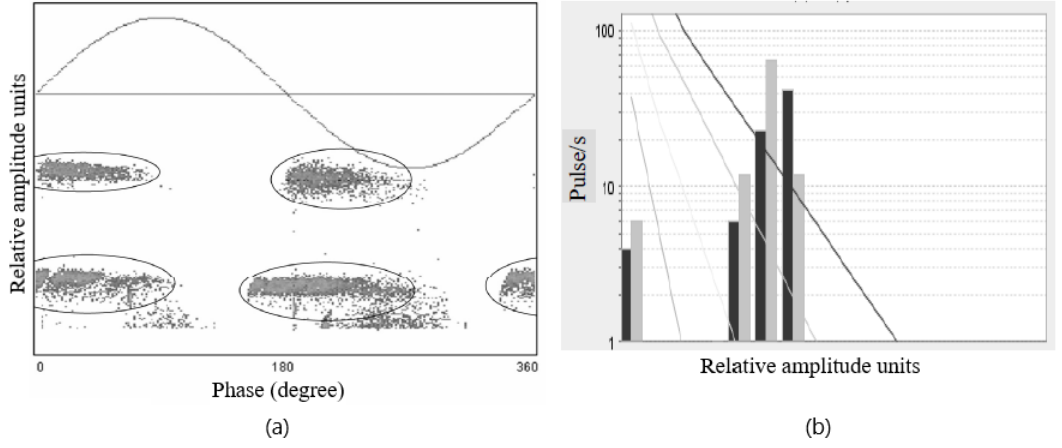
Figure 10. ( a ) PRPD pattern, ( b ) 2D equivalent [20,33].